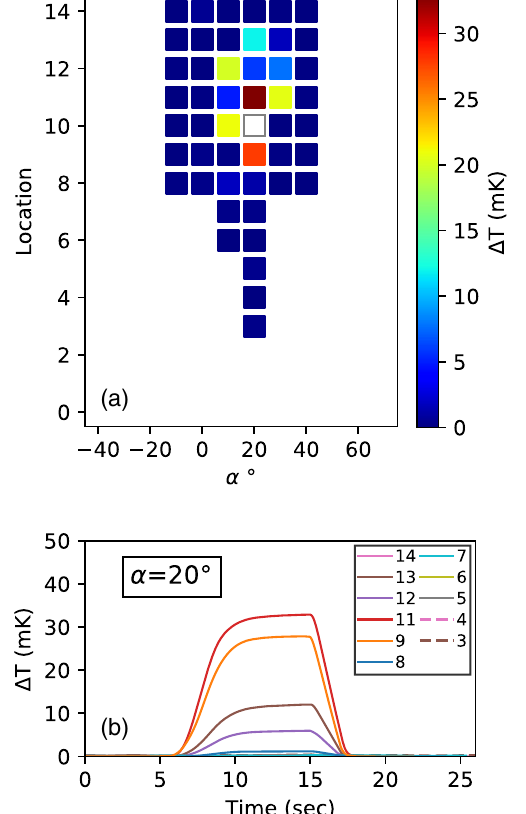
FIG. 7. The temperature rises during heating cycles with a pulsed rf operation. (a) shows temperature mapping results of the spatial spreading of heating by magnetic flux trapping at a local area of the cavity. (b) shows the time-series measurement of the heating observed at the sensors at the 20° board in plot (a). It is noted that these temperature mapping results were not simulta- neous because it takes time to switch channels.